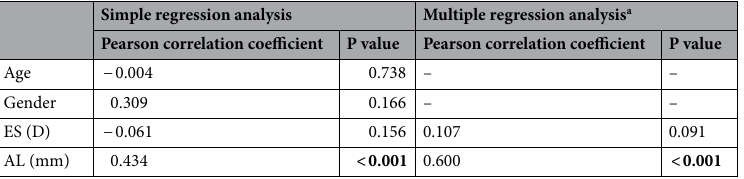
Table 3. The correlation between the distance which is between vortex vein ampulla and optic disc per eye and age, gender, logMAR visual acuity, equivalent spherical, and axial length. ES equivalent spherical, AL axial length. a These factors are selected by the backward forward stepwise method. Statistically significant results were written in bold